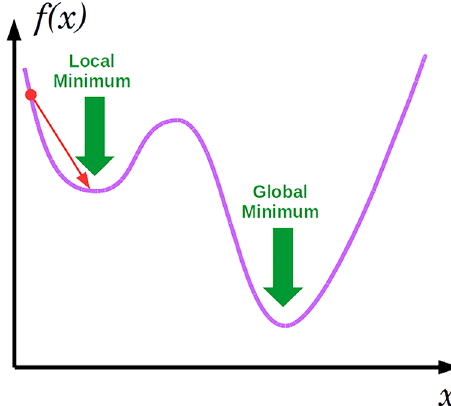
Figure 1. A mathematical function to abstractly represent an event or